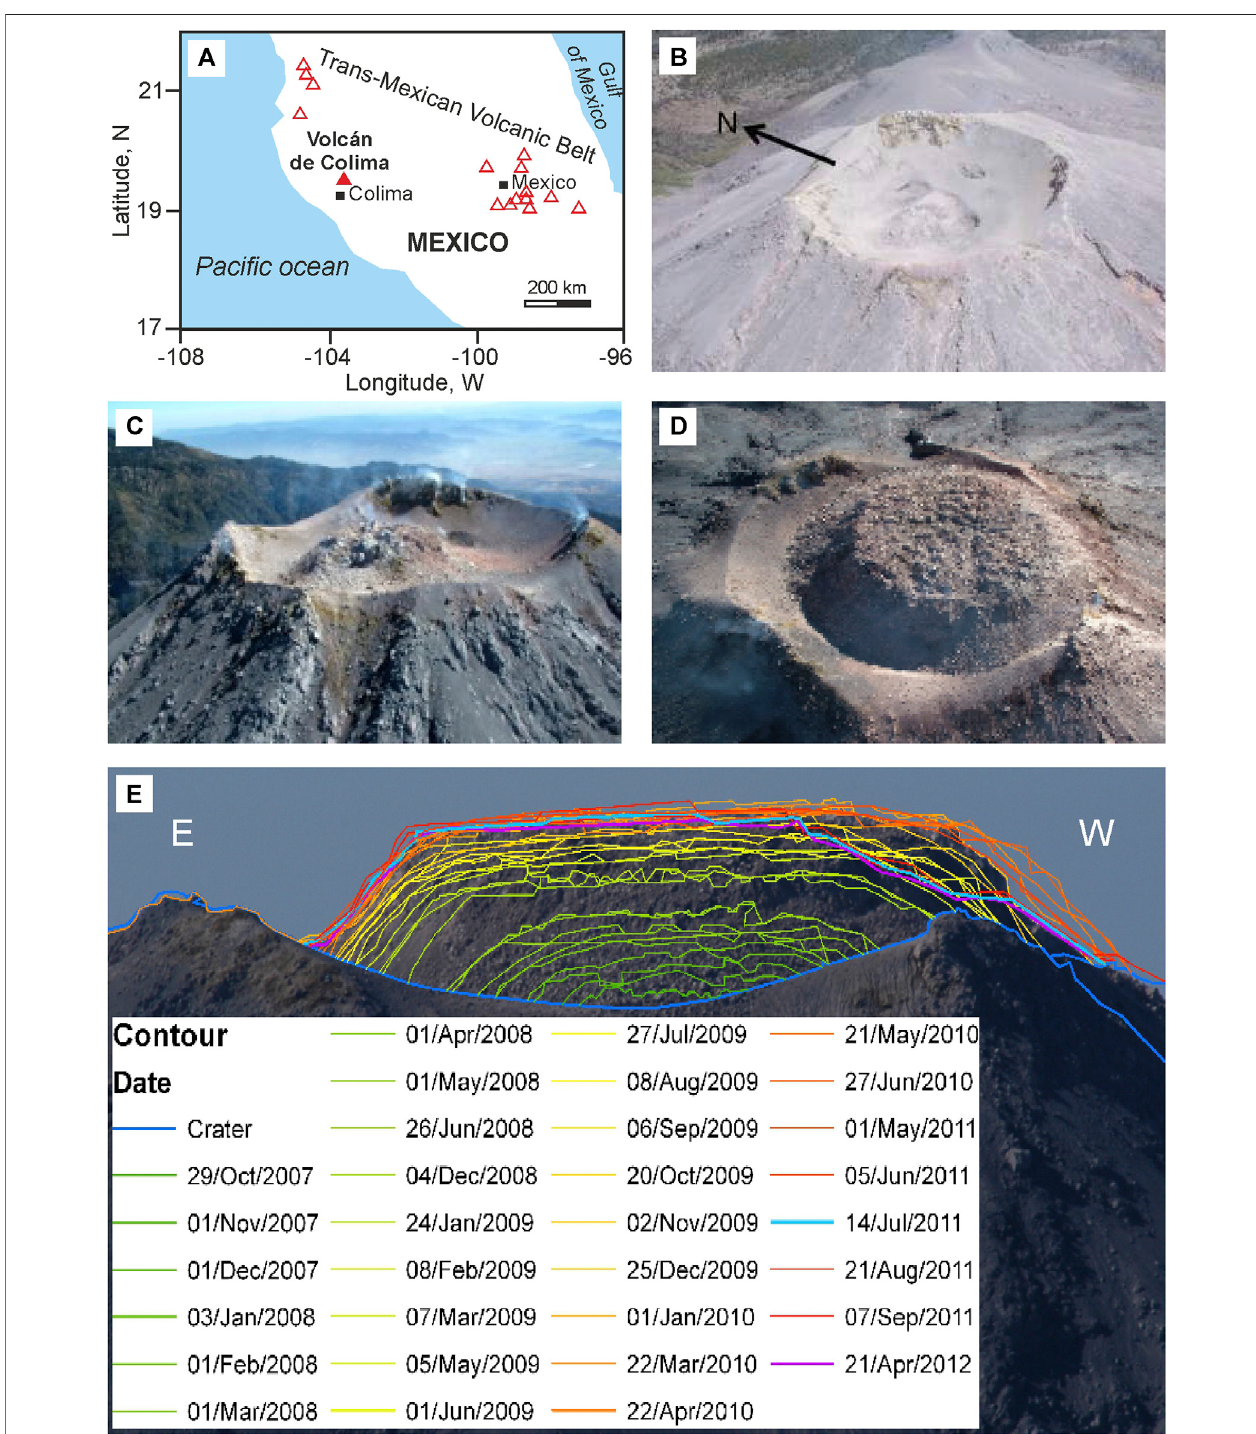
FIGURE1 | Lava dome growth at Volcán de Colima during 2007 – 2011. (A) Position ofVolcán deColimawithin the Trans-MexicanVolcanic Belt.Active volcanoes areshownwithtriangles;citiesareshownwithsquares. (B – D) PhotosofthegrowinglavadomeatVolcándeColimatakenlookingtowardthenortheaston (B) February 1, 2007, (C) March 8, 2008 and (D) November 25, 2009 (courtesy: Jalisco Civil Protection). (E) The contours of growing lava dome along the E-W pro fi le of the crater of Volcán de Colima for 2007 to 2012 (after Bretón-González et al., 2013, with permission of Nova Science Publishers).